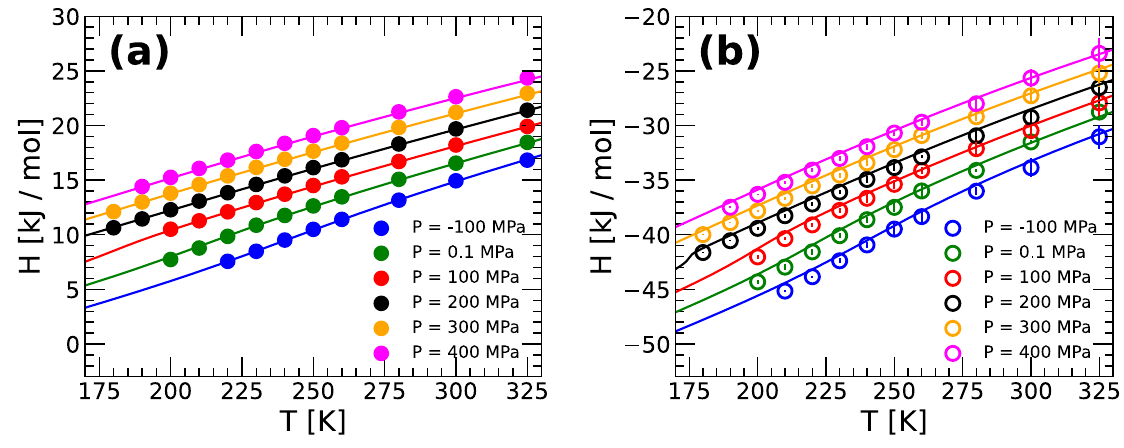
Figure 4. Enthalpy H ( T ) of q-TIP4P/F water as a function of temperature for selected pressures. Results are from ( a ) PIMD simulations (solid circles) and ( b ) classical MD simulations (empty circles). Lines are the corresponding H ( T ) obtained from the TSEOS. In both cases, the TSEOS predictions are in excellent agreement with the MD/PIMD simulation results.